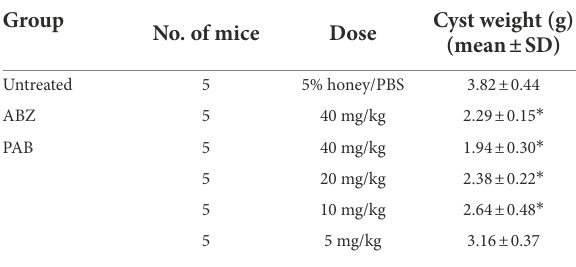
TABLE 1 Changes in the wet weight of E. multilocularis metacestodes in mice orally treated with PAB for 12 weeks after 3 months post- infection.